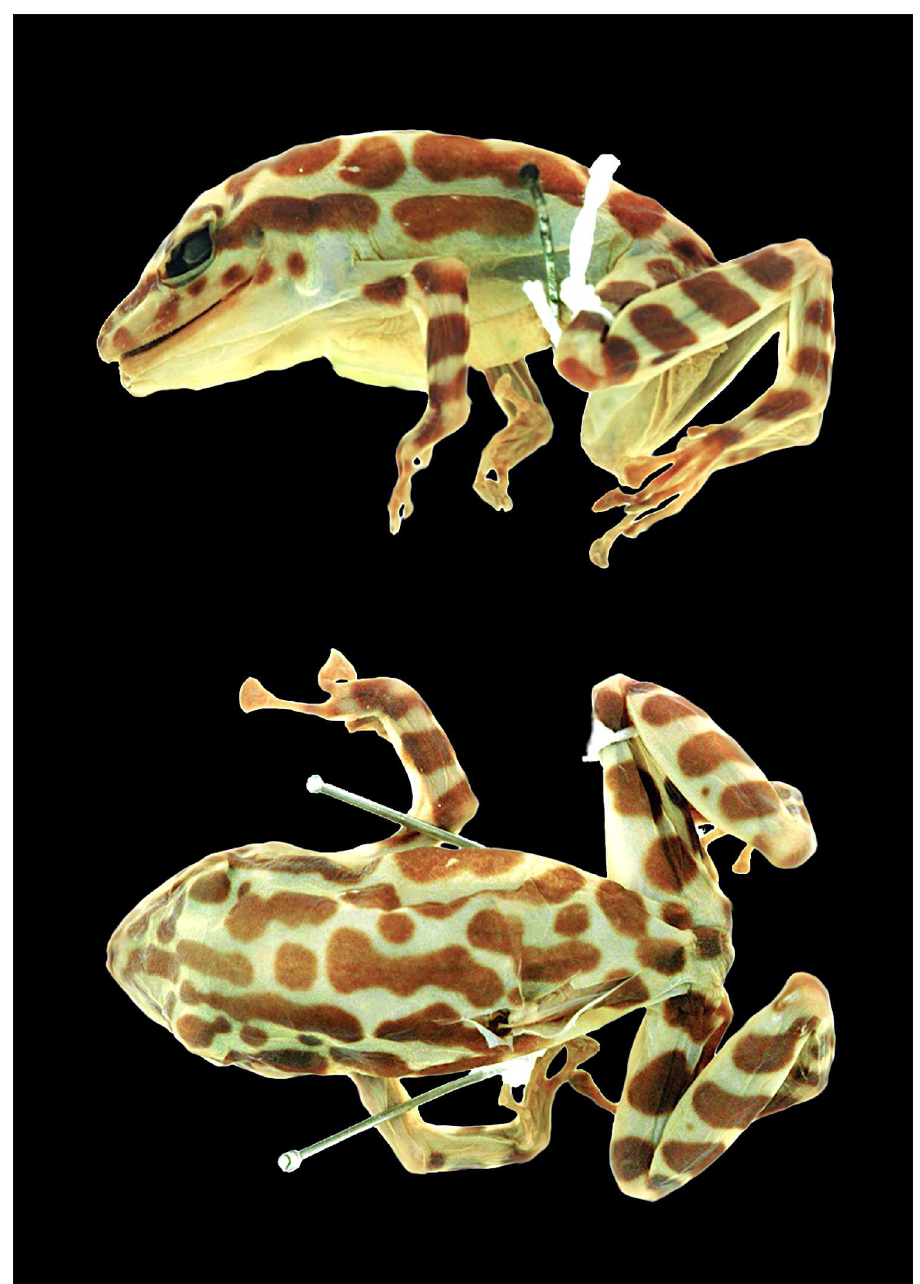
Fig 3. Holotype of Pristimantis ornatissimus , MNHNP 1906.264. Note matchingcolor patter with populations from near La Mana´ (Fig